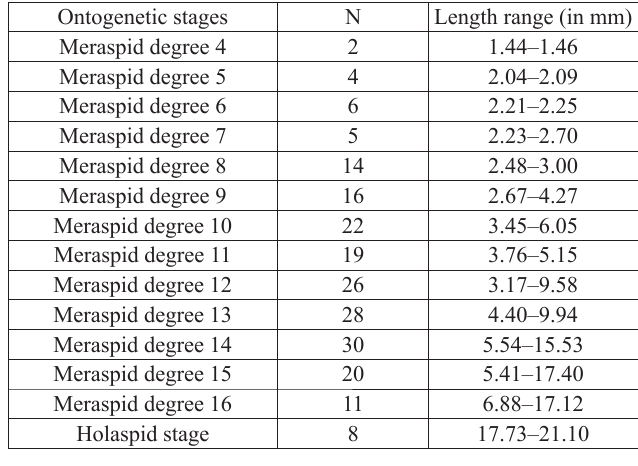
Table 1. Number of specimens (N) and length range of exoskeleton of Changaspis elongata at each ontogenetic